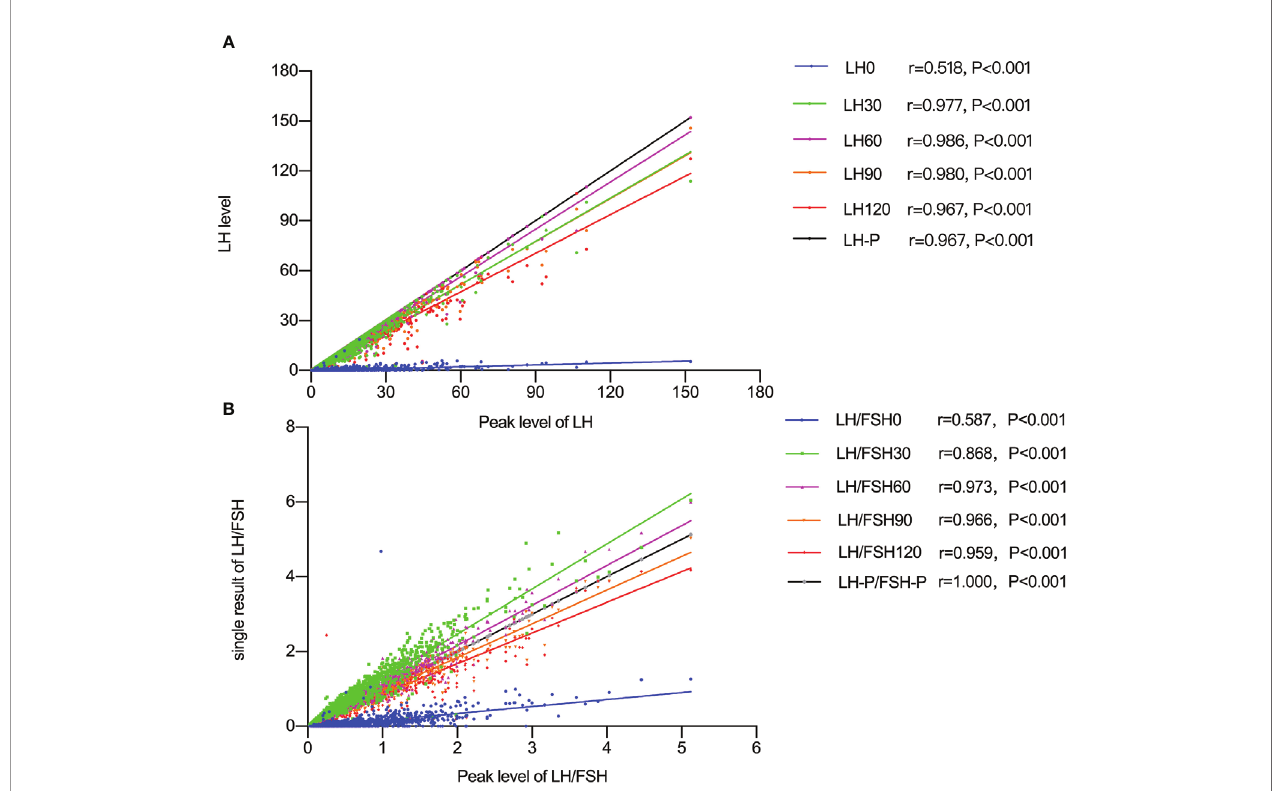
FIGURE 1 | (A) Spearman ’ s correlation results between peak LH and the level at 0, 60, 90, and 120 minutes after GnRH agonist stimulation. (B) Spearman ’ s correlation results between peak LH/FSH ratio levels and the level at 0, 60, 90, and 120 minutes after GnRH agonist stimulation.